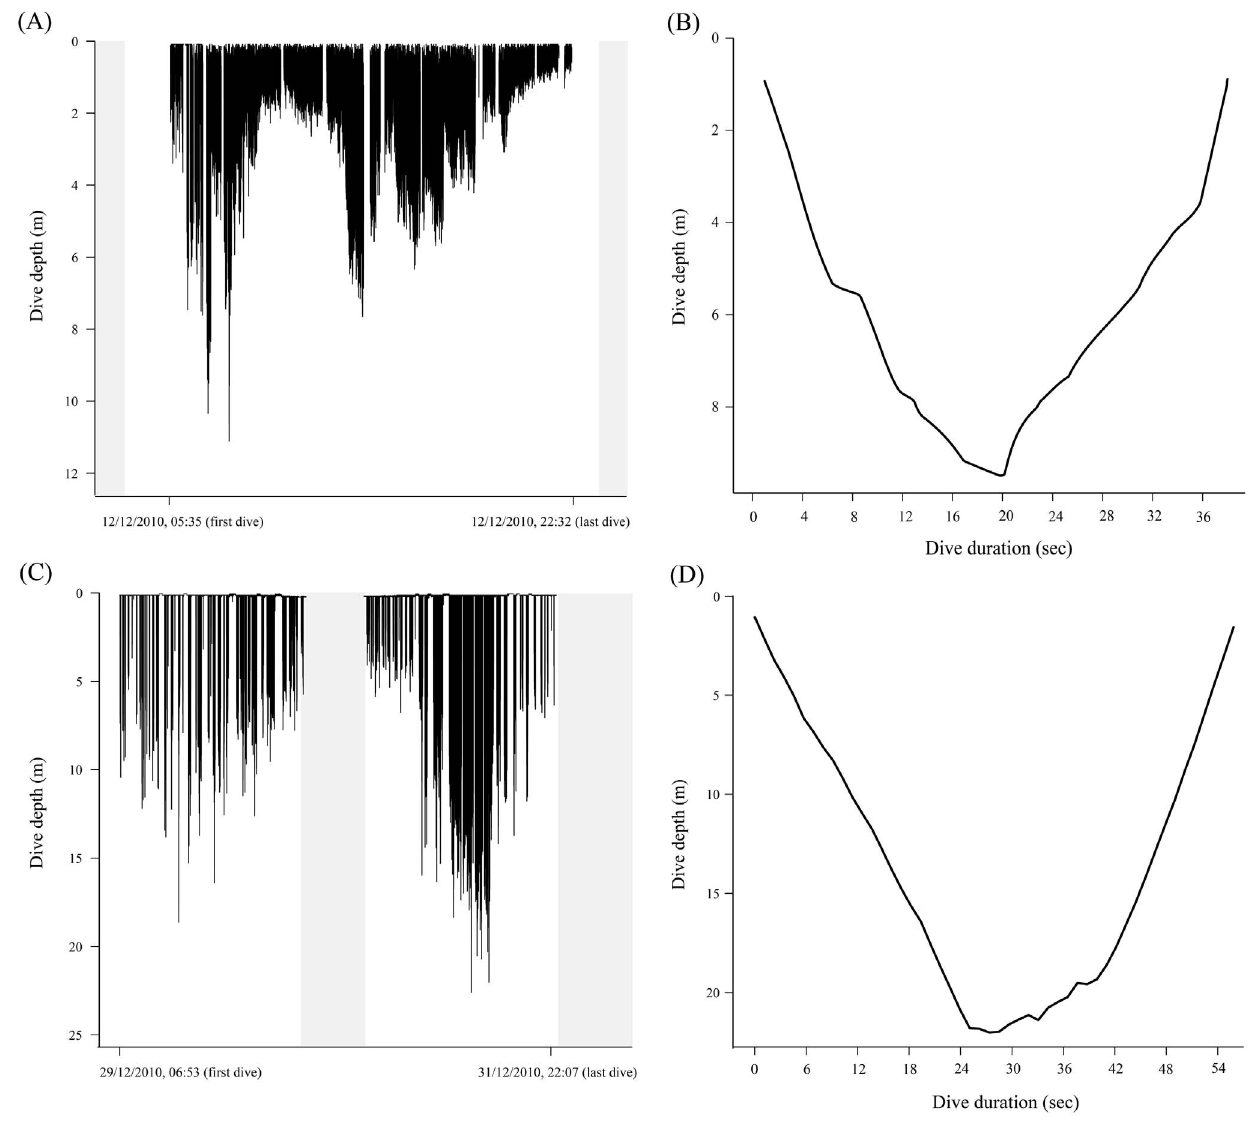
Figure 4. Example of the diving activity and a dive event of a common and a South Georgian diving petrel. Diving activity during the entire foraging trip and one dive of common diving petrel [(a) and (b), respectively] and South Georgian diving petrel [(c) and (d), respectively] measured with TDRs during incubation at Bird Island, South Georgia in summer 2010/11. Shaded areas indicate darkness.